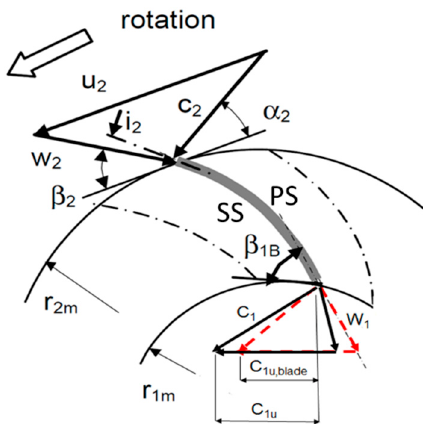
Figure 1. Velocity triangles at the inlet (2) and at the outlet of the runner (1). Both actual (solid line) and blade congruent (red dashed line) velocity triangles are represented at the outlet.